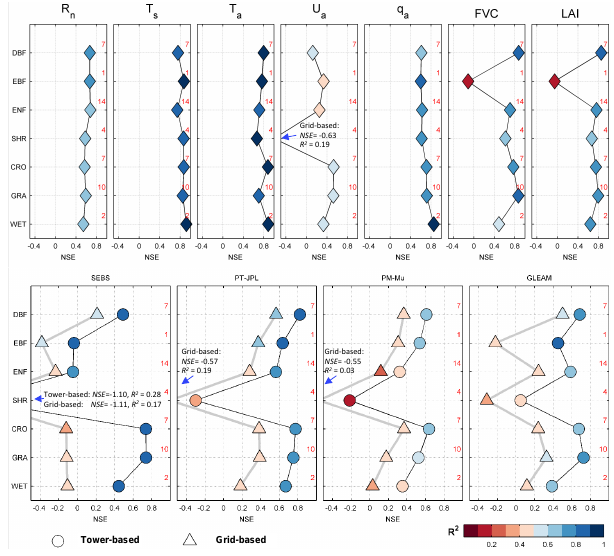
Figure 7. The upper panel presents Nash–Sutcliffe efficiency (NSE; x axis) and R 2 (colour tone) between tower- and grid-based val- ues for net radiation, land surface temperature, air temperature, wind speed, specific humidity, fractional vegetation cover and leaf area index, across the seven studied biome types. The lower panel presents the NSE ( x axis) and R 2 of model simulated evaporation against closure-corrected observed values. The number of towers for each biome type used in the analysis are shown in red font on the secondary (right) axis in each of the plots. Statistics for those results beyond the range of the x axis are printed separately on the